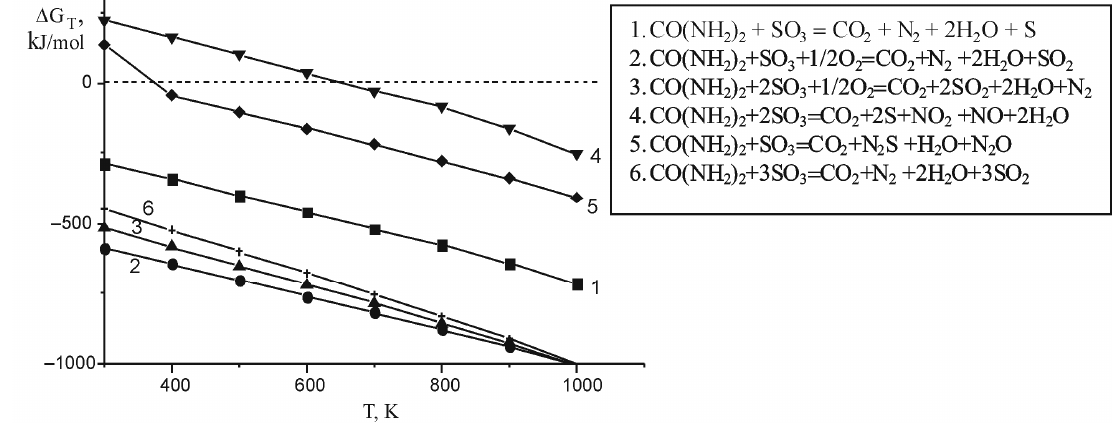
Fig. 4. The Gibbs’ energy value change dependency on temperature during carbamide reaction with sulphur (VI) oxide according to the equations presented in the diagram